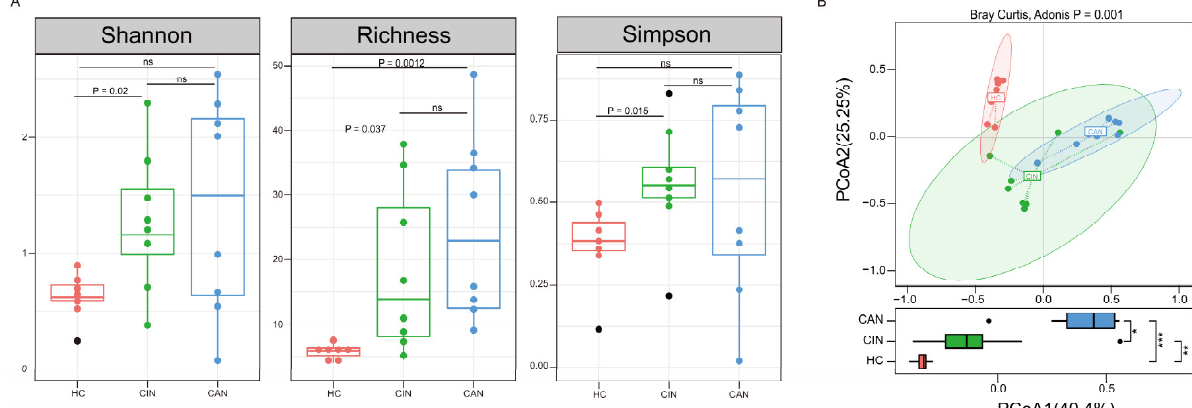
Figure 1. The differences in vaginal microbiota diversity by health status. ( A ) The boxplots display the differences in the alpha diversity indexes (Shannon index: left panel, Richness: middle panel, and Simpson’s index: right panel) between the groups. ( B ) Principal coordinate analysis (PCoA) plot depending on the Bray–Curtis dissimilarity of beta diversity, which colored each sample according to health status. The HC group shows lower inter-individual variations than the CIN and CAN groups at the PCoA axis1; * p < 0.05, ** p < 0.01, *** p <